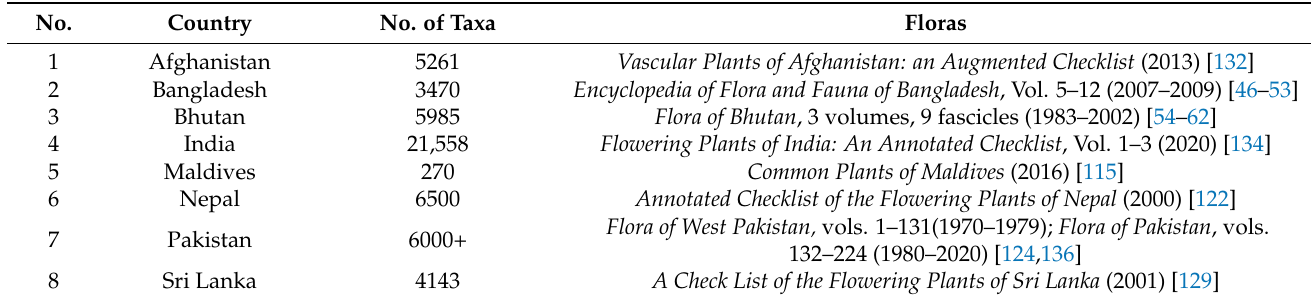
Table 2. The approximated numbers of taxa in South Asian countries.